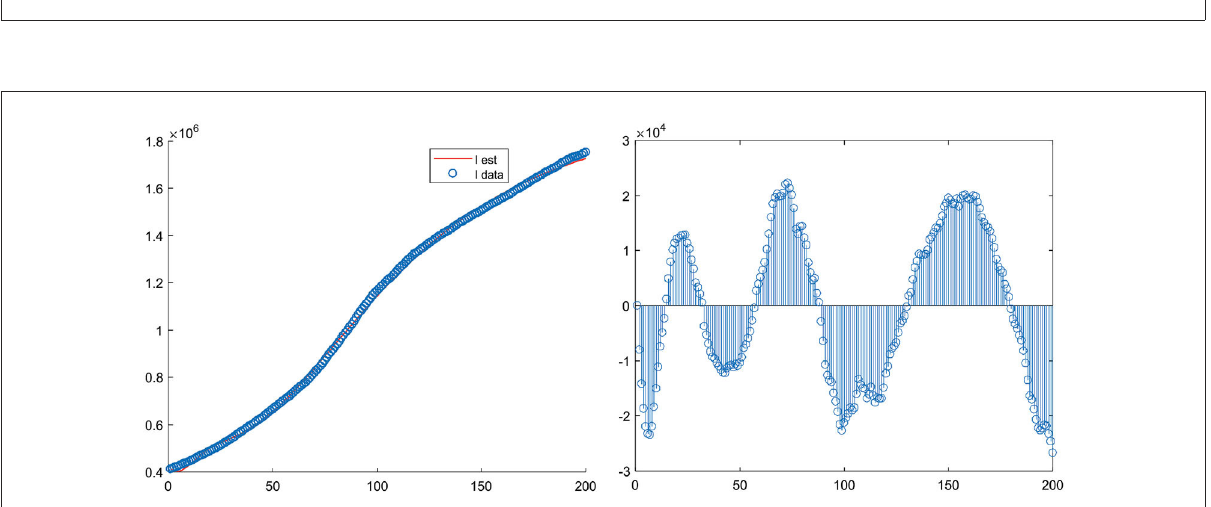
FIGURE2 Parameter fitting results from the COVID-19 model.